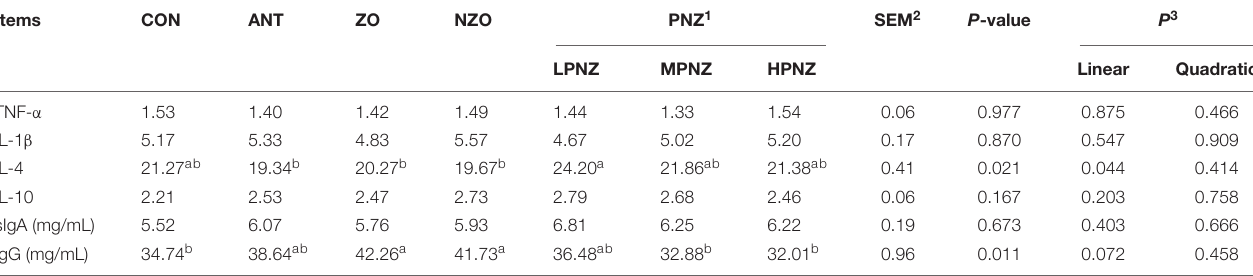
TABLE 6 | Effects of PNZ on the contents of cytokines and immunoglobulins in ileal mucosa of weaned pigs (ng/gprot). Items